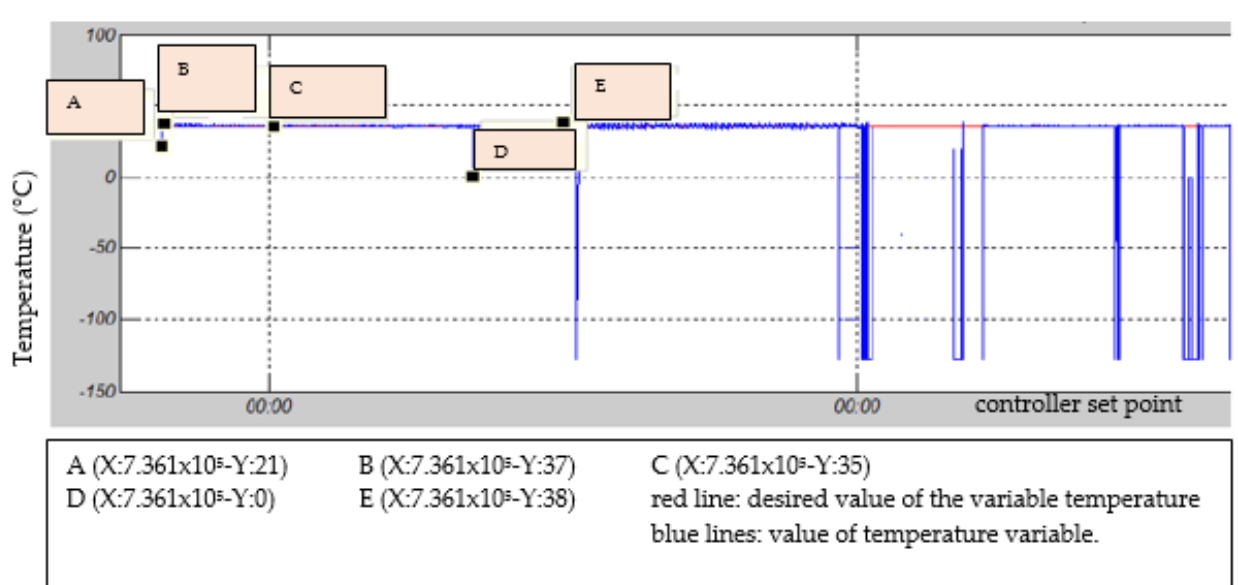
Figure 9. Temperature data for the water chamber of T1 Biodigester [9].